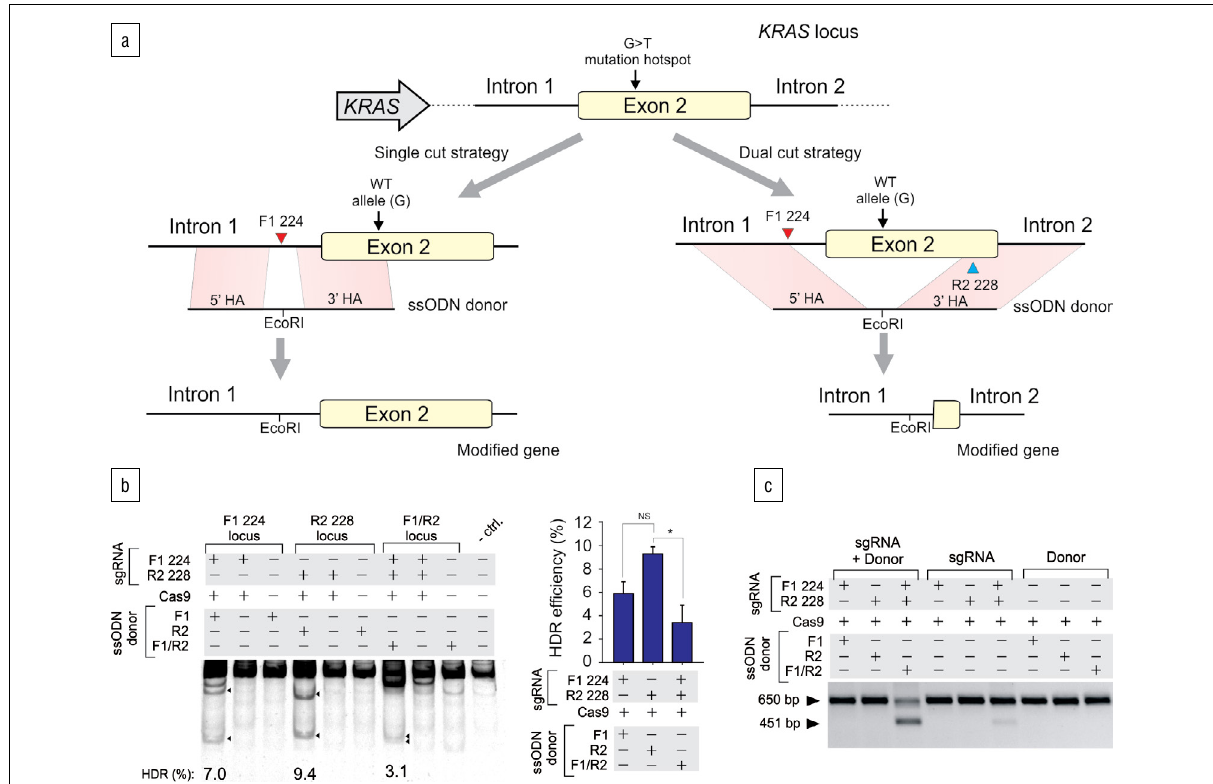
Figure 2: HDR of the individual DSBs and the micro-deletion with ssODNs. (a) 90-mer ssODNs were designed to repair DSBs from a single cut (sgRNA F1 224 or sgRNA R2 228) (left) as well as a micro-deletion from the use of a dual cut (both sgRNA F1 224 and sgRNA 228) (right). The homology arms of the ssODNs for the repair of single cuts flanked sequences directly adjacent to their respective DSBs. The micro-deletion repair ssODN was designed to flank distal sequences that were outside of the F1 224 and R2 228 DSBs. Each ssODN carried the EcoRI recognition site that was targeted for integration into the repair site. (b) Restriction fragment length polymorphism analysis of the PCR products demonstrated the HDR of single DSBs and the micro-deletion as the genomic integration of the EcoRI restriction site ( n =3; mean±SD, * p <0.05, unpaired Student’s t -test). (c) PCR products of the repaired region amplified from gDNA, showing the full length (650 bp) and the deletion amplicons (451